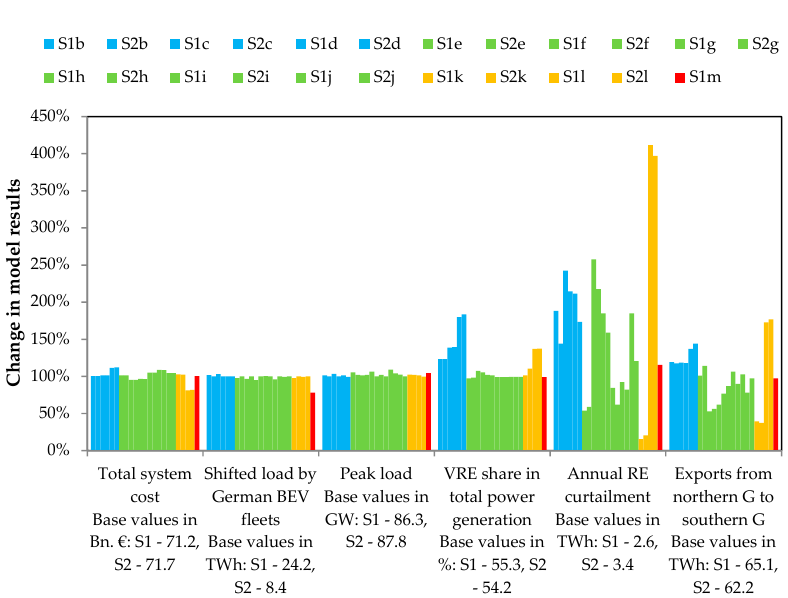
Figure A15. Relative sensitivity of annual energy system model results analyzed in Section 3.2. Each result value (of S1x, S2x) is divided by result values of baseline (S1, S2) values respectively. Blue bars show the results for the model runs with lower CO 2 limit, green those with different weather years, yellow those with different fluctuating RE specific investment assumptions and red that with lower BEV charge control availability.